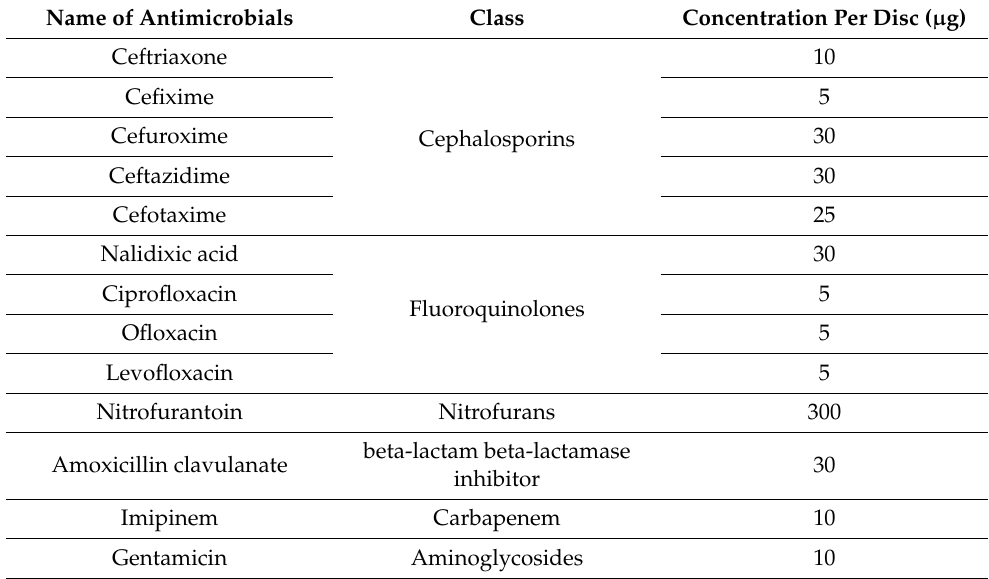
Table 8. The antimicrobials and concentrations of discs for susceptibility assay for E. coli . Name of